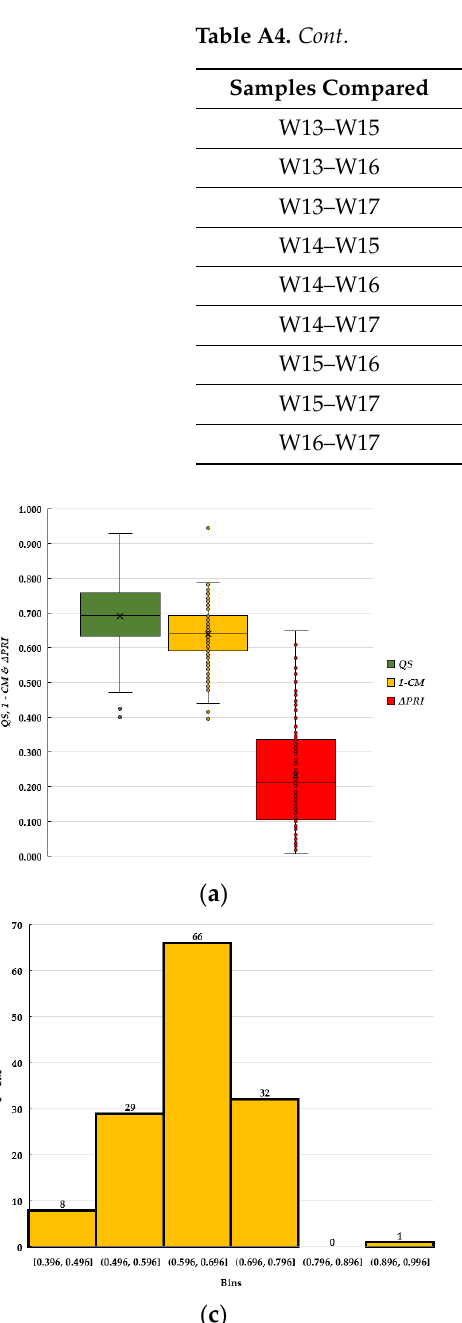
Figure A1. Descriptive statistics supporting case study 3. Legend: ( a )—descriptive statistics of QS , 1 − CM and Δ PRI ; ( b )—histogram of QS ; ( c )—histogram of 1 − CM ; ( d )—histogram of Δ PRI.